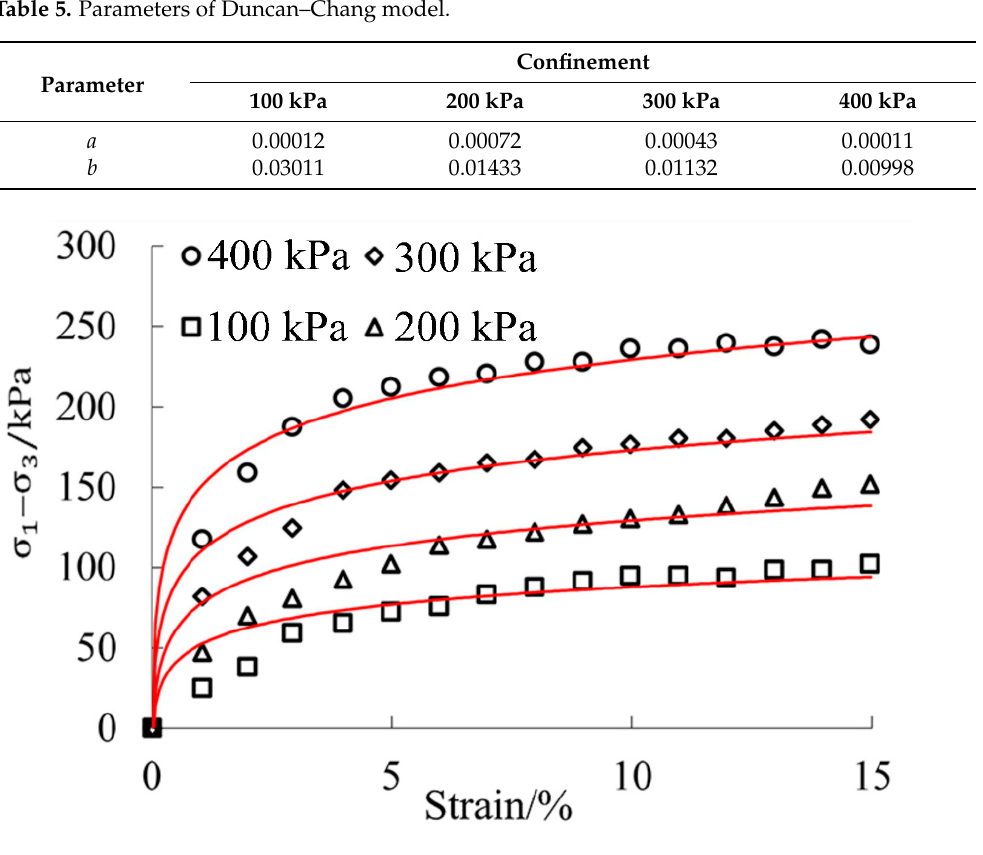
Figure 12. Fitting results of remolded soil adopting the Duncan–Chang model.